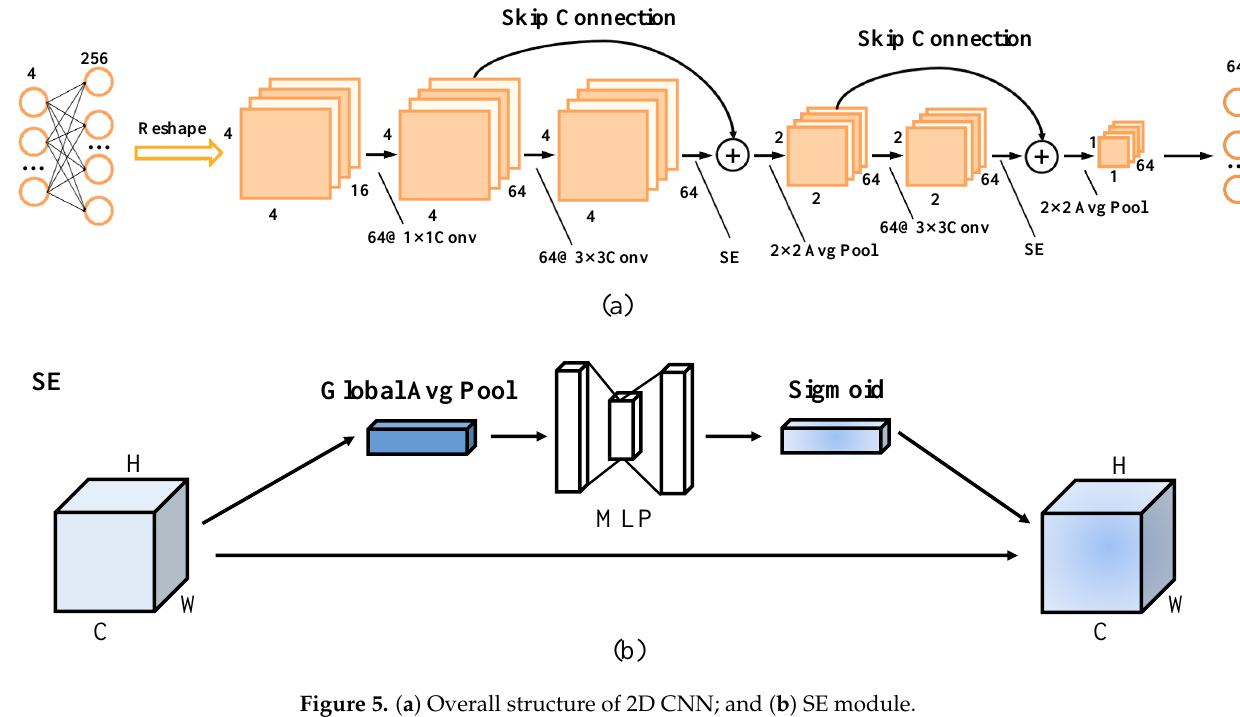
Figure 5. ( a ) Overall structure of 2D CNN; and ( b ) SE